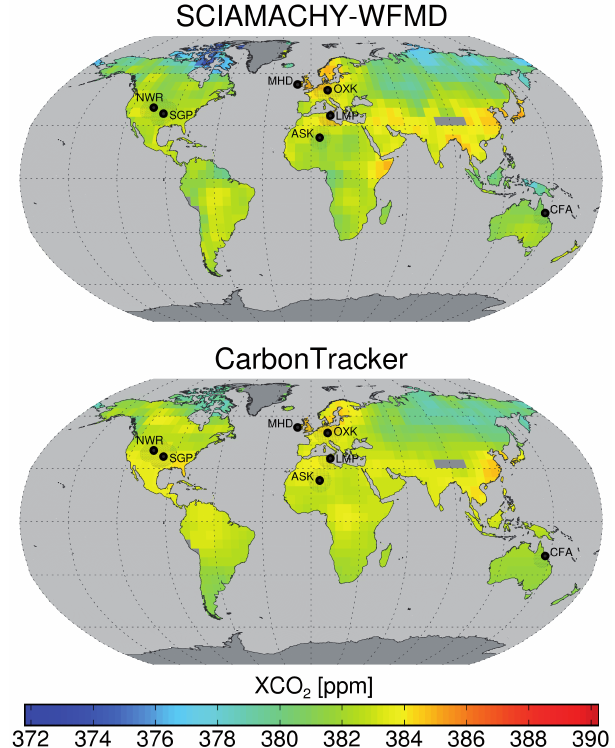
Fig. 1. Spatial distribution of SCIAMACHY and CarbonTracker XCO 2 for the year 2007 and the observational site locations used to derive the linear regression parameters: Niwot Ridge (NWR), Southern Great Plains (SGP), Mace Head (MHD), Ochsenkopf (OXK), Lampedusa (LMP), Assekrem (ASK), and Cape Ferguson (CFA). CarbonTracker has been sampled at the time and location of the SCIAMACHY measurements.